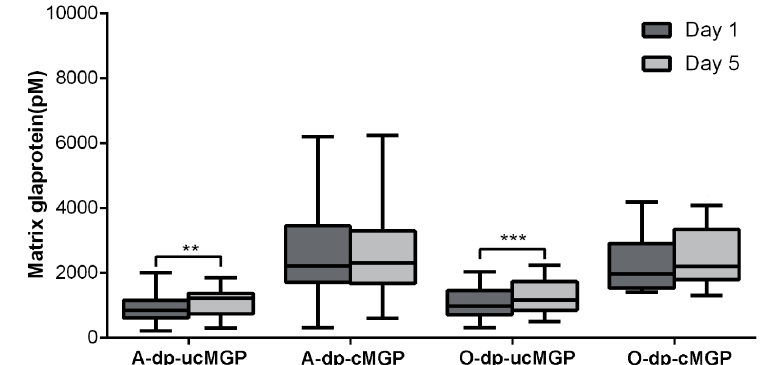
Figure 2. Boxplot changes in MGP before surgery and five days postoperatively (A = abdominal surgery, O = orthopaedic surgery, dp-ucMGP = desphospho-uncarboxylated matrix Gla protein, and dp-cMGP = desphospho-carboxylated matrix Gla protein). Significance levels: ** p ≤ 0.01 and *** p ≤ 0.001.